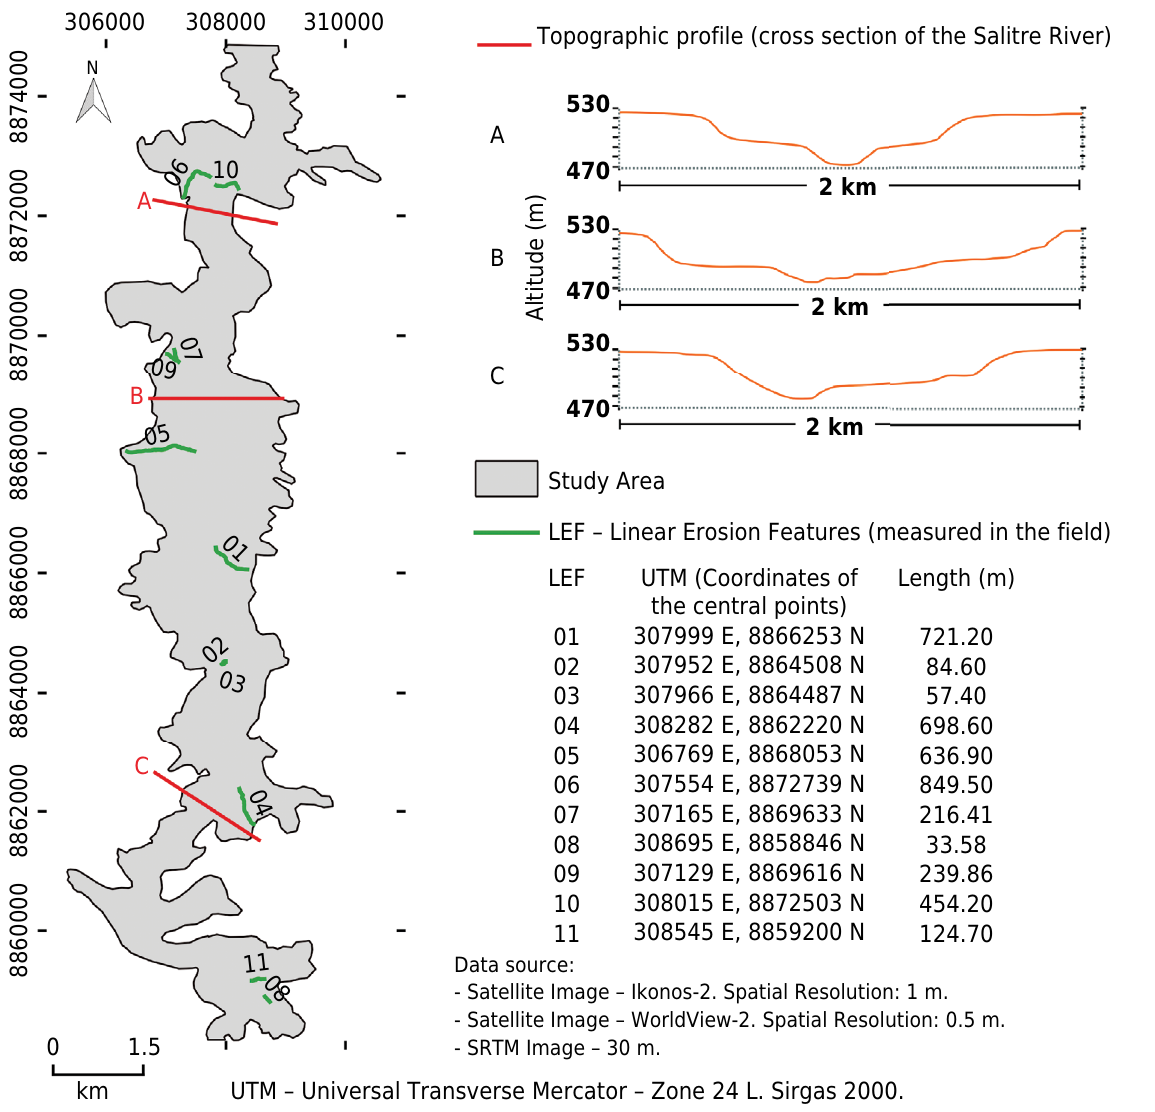
Figure 2. The map presents the spatial distribution of LEFs (linear erosion features) obtained from the field measurements and show the topographic profiles (cross-section of the Salitre River) in the studied